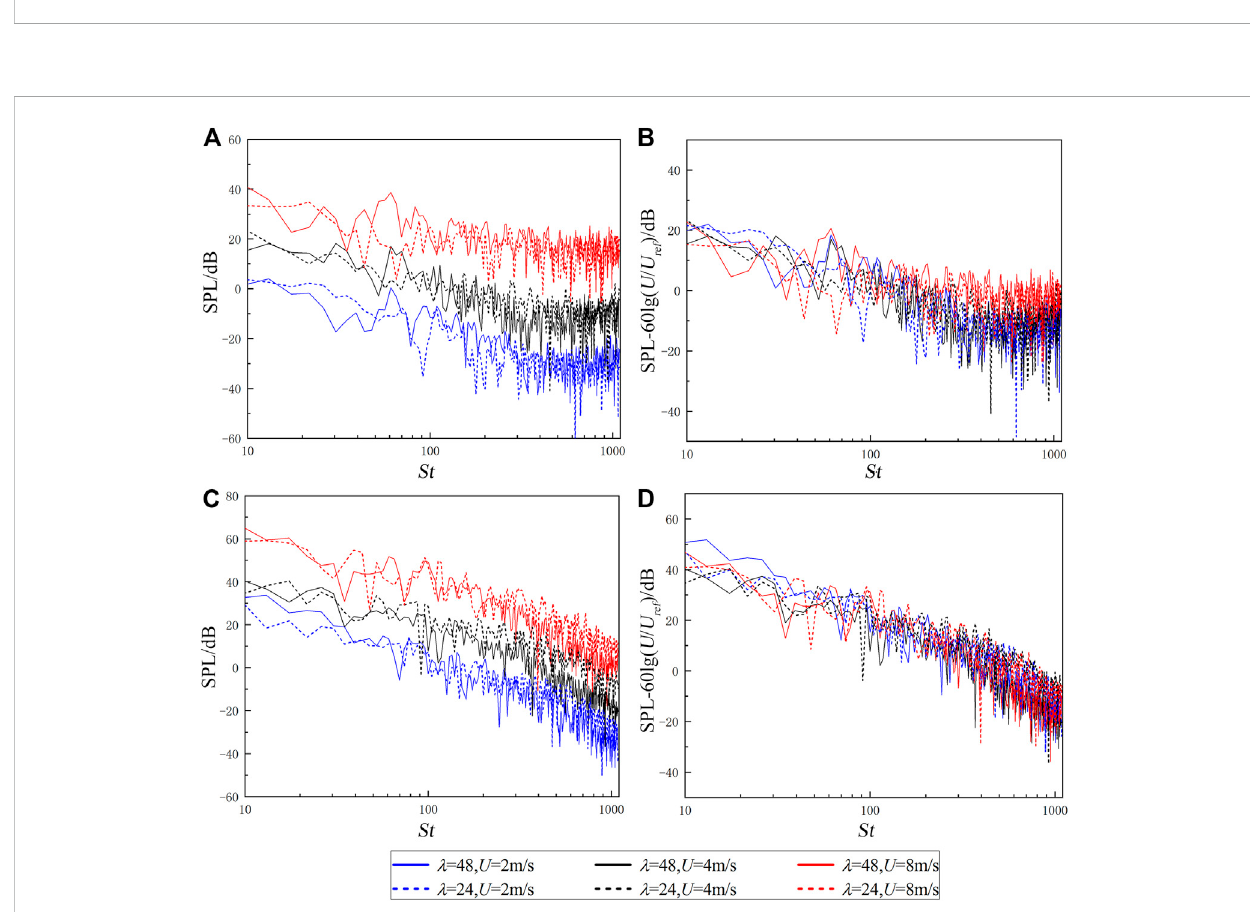
FIGURE 10 SPL spectrums of Z = 0 plane under different conditions. (A,B) Calculated results and normalized results of the 0 ° measuring point. (C,D) Calculated results and normalized results of the 90 ° measuring